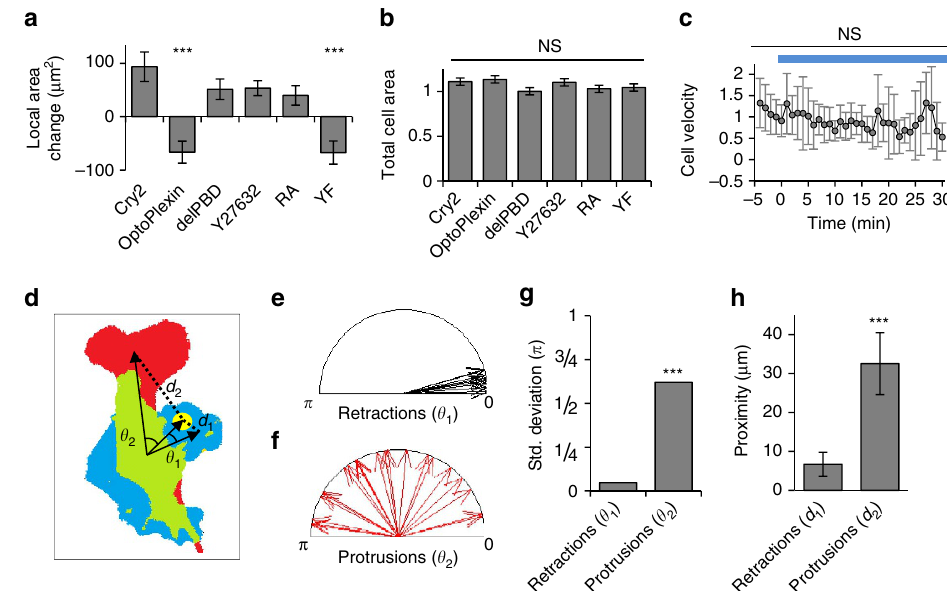
Figure 5 | Effects of local activation of optoPlexin on cell morphology and motility. Effects on the illuminated protrusions ( a ), measured in a 50 m m-diameter circle centred at the region of illumination, and total cell areas ( b ) after 7.5min of local illumination in MC3T3-E1 cells expressing Cry2, optoPlexin, optoPlexin-delPBD, optoPlexin and pretreated with 10 m M Y-27632 ROCK inhibitor, and optoPlexin-RA, n ¼ 9–14 cells. ( c ) Cell centroid velocities at different times upon local activation of optoPlexin in MC3T3-E1 cells. Blue line, illumination at 440nm, n ¼ 21 cells. ( d ) The locally induced retraction (blue) and the distal protrusion (red) after pulses of illumination (yellow) of an optoPlexin-expressing cell was illustrated in a morphology diagram. The overlapping cell area before and after illumination was labeled in green. Based on the centroids of these colour-coded regions, y 1 and y 2 were used to describe the angles of retraction and protrusion relative to the direction from the centroid of the cell at time 0 to the centre of illumination, respectively. Similarly, d 1 and d 2 indicated their centroid distances to the region of illumination, respectively. ( e , f ) Angles of retraction and protrusion induced by local activation of optoPlexin in MC3T3-E1 cells and ( g ) s.d. of their distribution, n ¼ 14 cells. ( h ) Proximity of retractions and protrusions induced by local activation of optoPlexin in MC3T3-E1 cells to the region of illumination, n ¼ 14 cells. For a , b , c , h , means ± s.e.m are shown, *** P o 0.001 and * P o 0.05, NS, not significant, Student’s t -test. For g , *** P o 0.001 and * P o 0.05, NS, not significant, F-test.